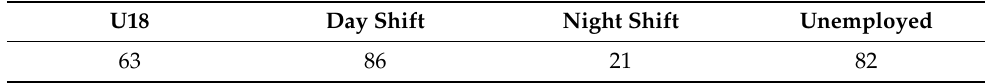
Table 2. Classification of the 252 Residents of the